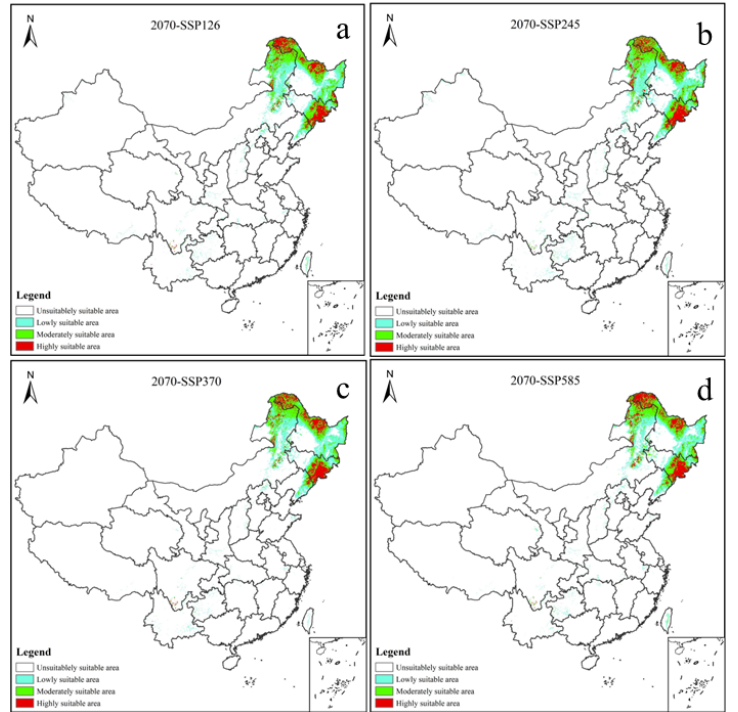
Figure 6. Prediction of the potential distribution of V. uliginosum in China under future climatic scenarios (2070s). ( a ) Potential distribution of V. uliginosum in China under the 2070s-SSP1-2.6 scenario; ( b ) Potential distribution of V. uliginosum in China under the 2070s-SSP2-4.5 scenario; ( c ) Potential distribution of V. uliginosum in China under the 2070s-SSP3-7.0 scenario; ( d ) Potential distribution of V. uliginosum in China under the 2070s-SSP5-8.5 scenario.